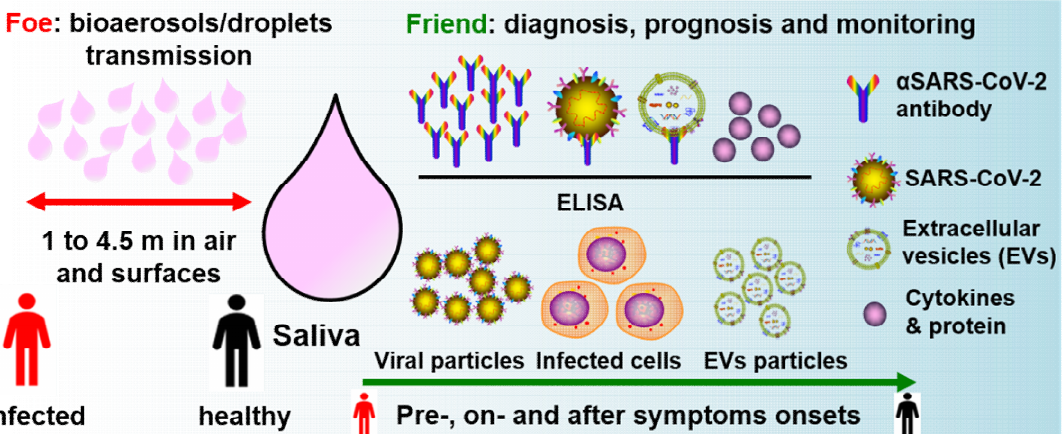
Figure 3. Saliva as a friend and foe in the fight against COVID-19. Saliva has a role in human-to-human transmission via bioaerosols and droplets. Salivary proteins and anti-SARS-CoV-2 antibodies, viral particles, EVs, and infected host cells can be potential diagnostic, prognostic, and COVID immunity monitoring biomarkers, for both symptomatic and asymptomatic patients. EVs: extracellular vesicles; ELISA: enzyme-linked immunosorbent assay.